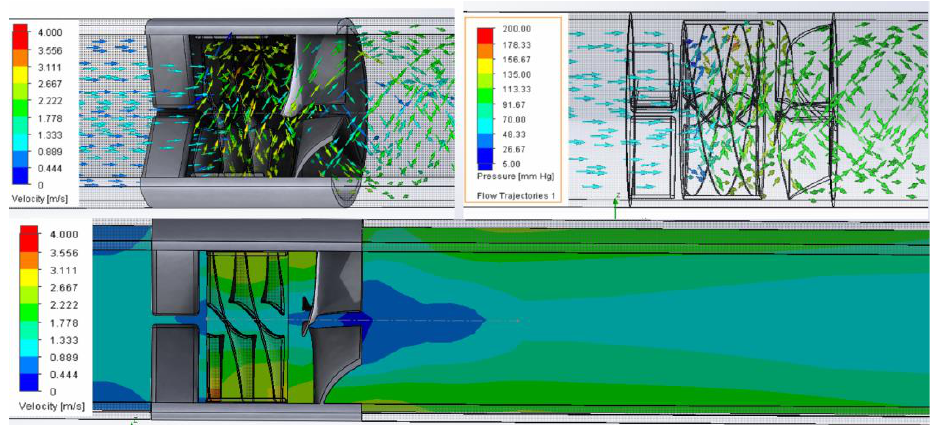
Figure 5. CFD analysis shows flow trajectories ( top ) with velocities ( top left ), pressures ( top right ) and trans-axil plane velocities ( bottom ).